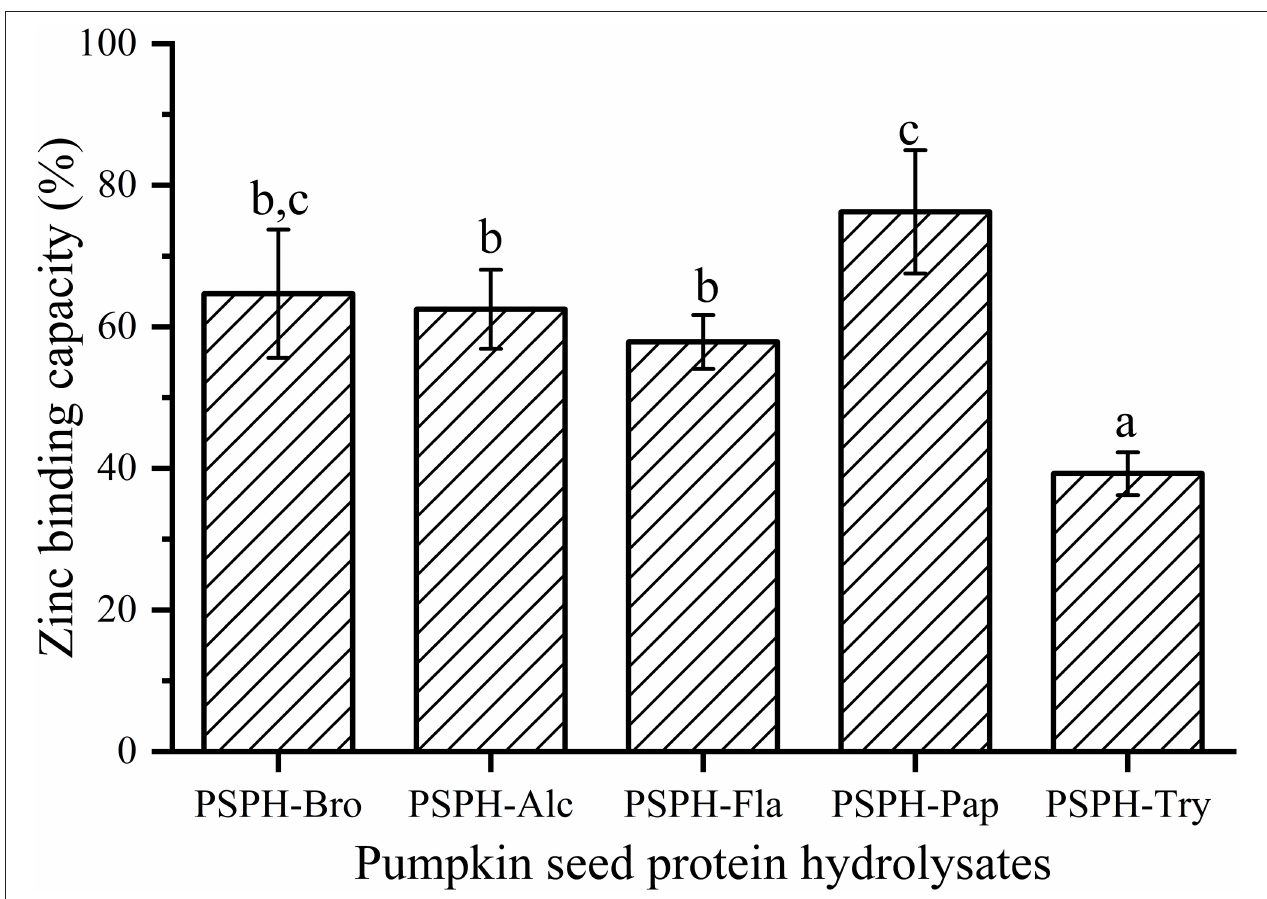
FIGURE 5 | Zinc binding capacity of pumpkin seed protein hydrolysates produced with bromelain (PSPH-Bro), alcalase (PSPH-Alc), flavourzyme (PSPH-Fla), papain (PSPH-Pap), trypsin (PSPH-Try) after hydrolysis 3h in a 2% (w/w) enzyme to substrate ratio. Different letters represent significantly different mean values with P < 0.05.